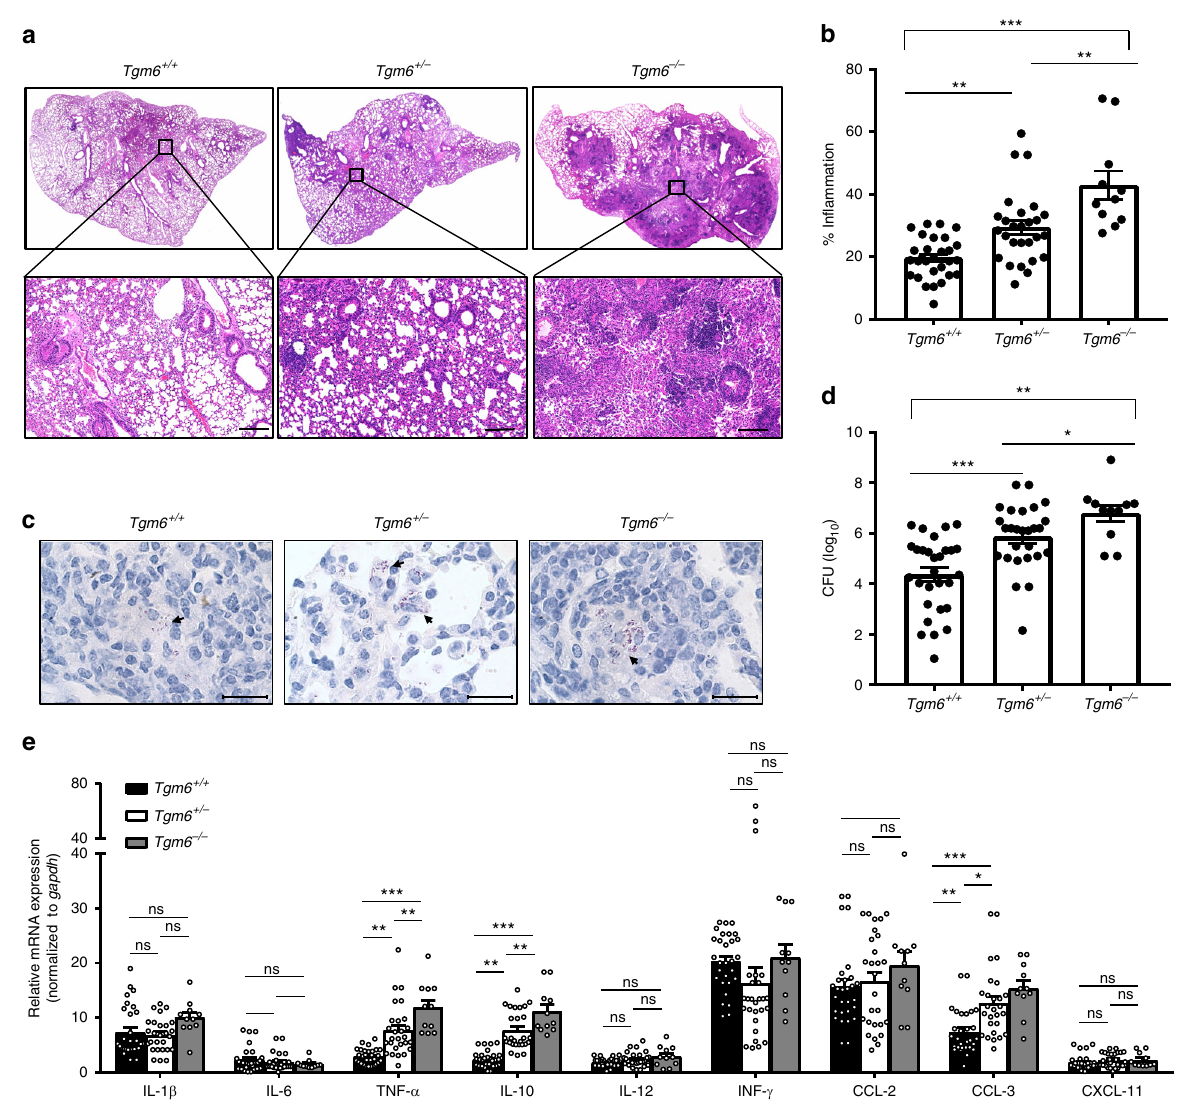
Fig. 3 Tgm6 − / − mice are more susceptible to Mtb infection. a H&E staining of the lungs from Mtb -infected mice of indicated genotype. The upper row showing the representative picture of the whole lobe of the stained lung from mice. The lower row showing the enlarged vision of the selected region. Scale bar, 200 µ m; magni fi cation: ×100. b Results showing the quanti fi cation of the percentages of in fl ammation regions as measured by H&E staining in one lobe of the lung from mice of indicated genotype. Data shown are mean ± SEM. One-way ANOVA followed by the Bonferroni post hoc test were used for statistical analyses. c Representative results of acid-fast staining of Mtb in the lungs from mice infected with Mtb . Scale bar, 20 µ m; magni fi cation: ×1000. d The bacterial burden in the lungs from Mtb -infected mice was measured by a CFU assay. Data were presented as the medians ± interquartile ranges and were analyzed by the Mann – Whitney U test. e Quantitative RT-PCR measurement of the mRNA levels (normalized to gapdh ) of cytokines and chemokines in lungs from infected mice of indicated genotypes. The data for tgm6 + / + ( n = 29) and tgm6 + / − ( n = 27) mice were pooled from four independent experiments and the data for tgm6 - − / − mice ( n = 11) were pooled from two independent experiments. Data shown were mean ± SEM. One-way ANOVA followed by the Bonferroni post hoc test were used for statistical analyses. ∗ P < 0.05; ∗∗ P < 0.01; ∗∗∗ P < 0.001; ns, not signi fi